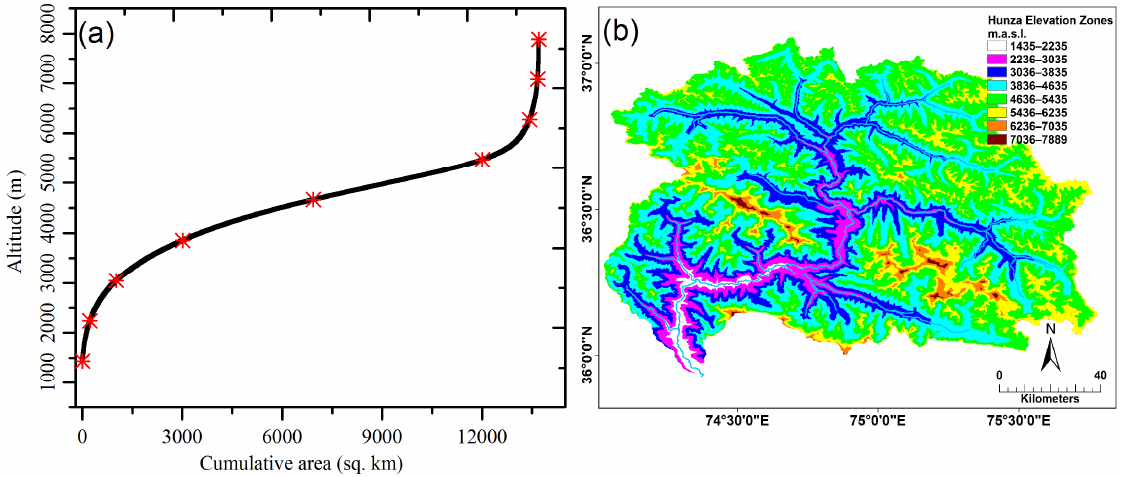
Figure 2. ( a ) Cumulative area vs. elevation curve used for hypsometric mean elevations within the study area (red asterisks represent boundaries among elevation zones). ( b ) Hunza basin elevation zones and the drainage